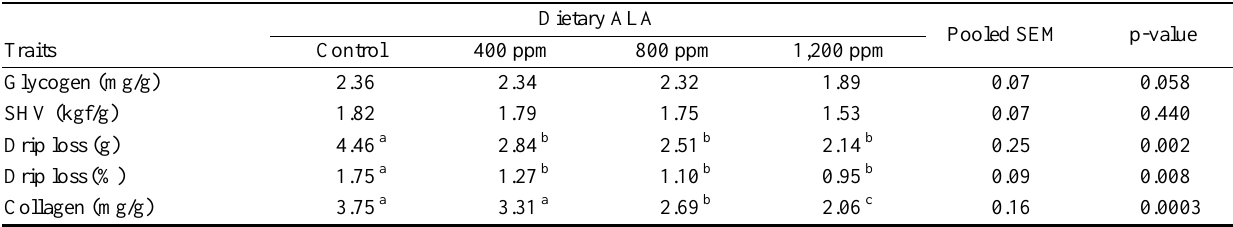
Table 5. Effects of dietary ALA on the meat quality of broilers